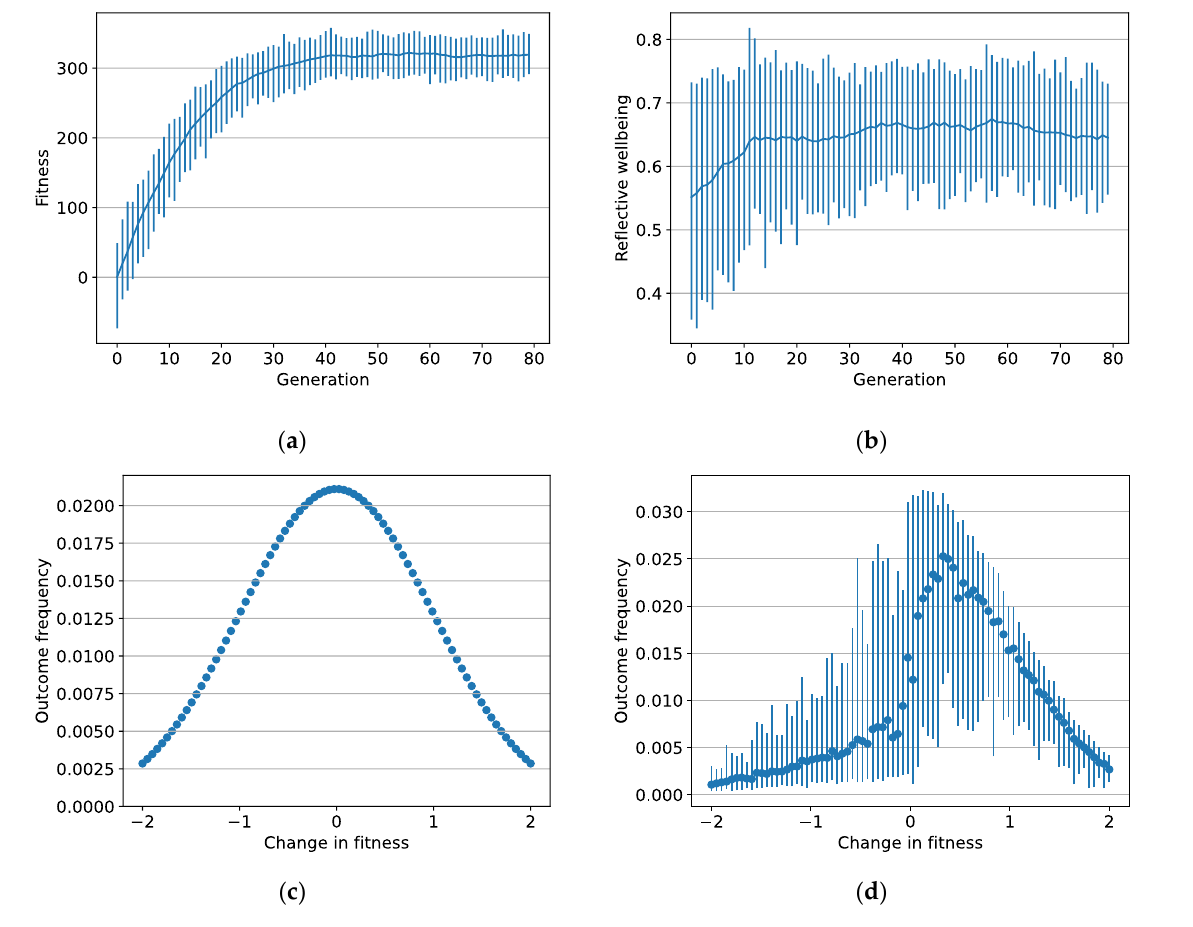
Figure 2. ( a ) Mean fitness across the population for each generation; ( b ) mean reflective wellbeing across the population for each generation; ( c ) frequency of outcomes in the first period of the first generation; ( d ) frequency of outcomes in the last period of the last generation. Points represent population means for the 80 situations, and vertical bars indicate the ranges within the